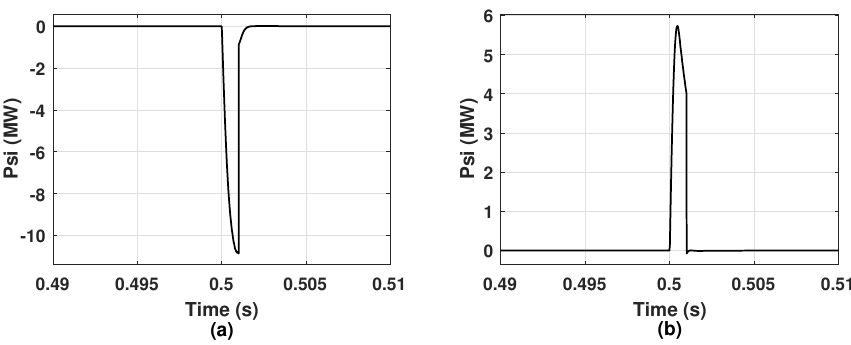
Figure 8. Superimposed power flow for a fault at ( a ) F 1 and ( b ) F 2 measured at the relay A1.